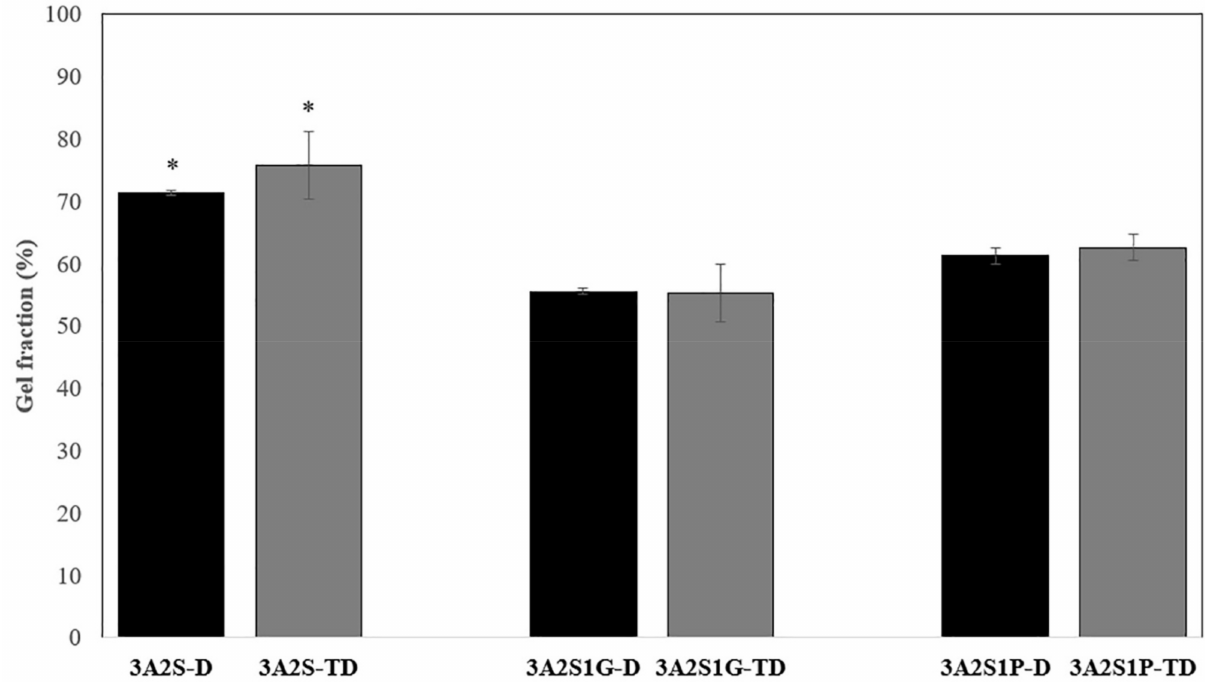
Figure 4. Percentage of gel fraction of scaffolds (3A2S, 3A2S1G, 3A2S1P) that were prepared by the freeze-drying method (D) (black box) and by freeze-thawing together with the freeze-drying method (TD) (grey box) (* significant difference compared to other formulations; p <